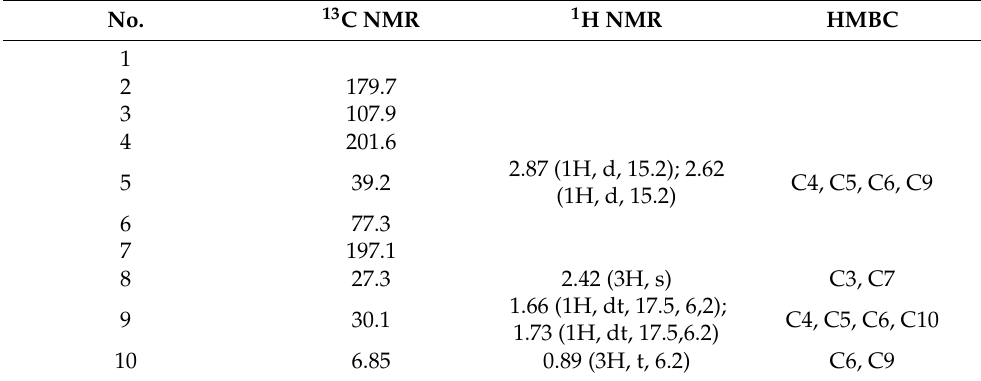
Table 3. NMR data of compound 3 (500 MHz for 1 H NMR, 125 MHz for 13 C NMR, CD 3 OD). No. 13 C